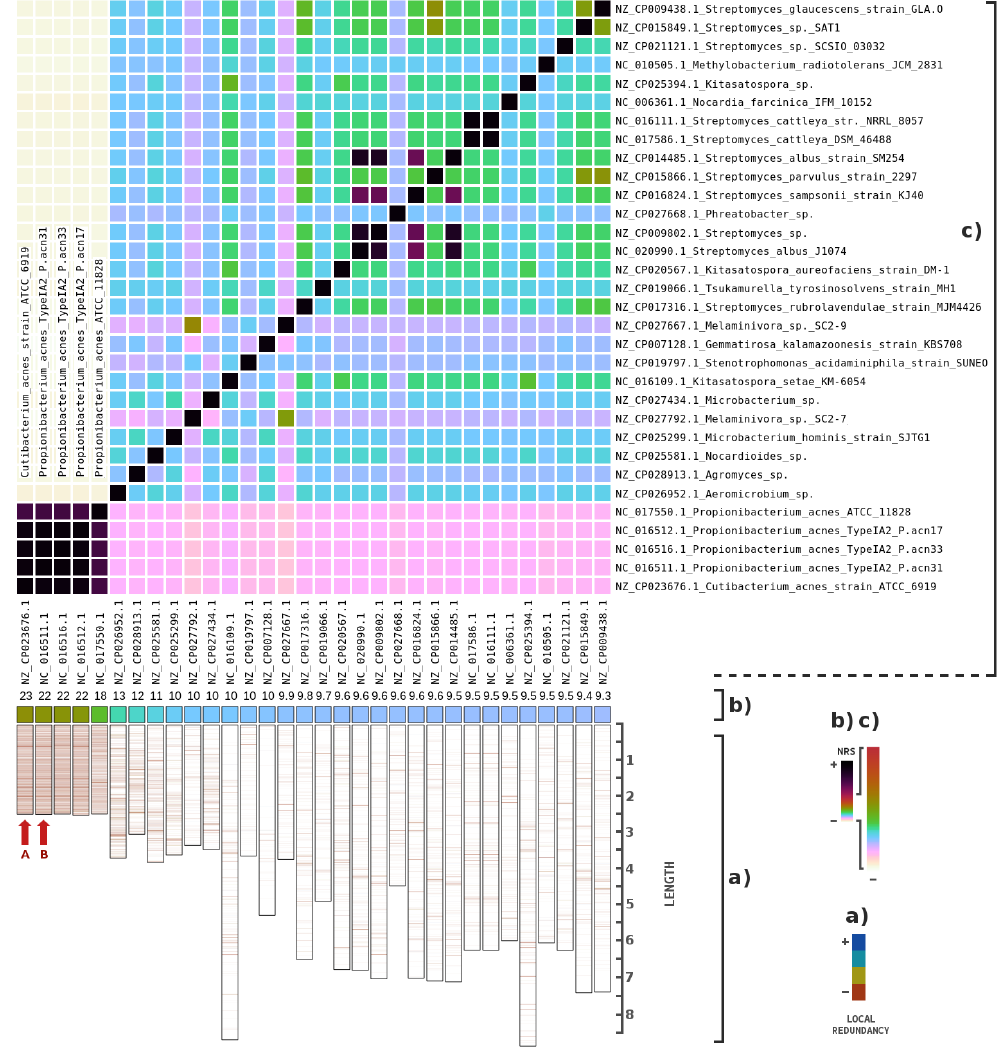
Figure 6. Metagenomic composition analysis of the PUM sample, specifically for bacterial genomes: ( a ) the local similarity (redundancy) of the highest NRS entries in descending order (from left to right), according to the order of the names at the top (from bottom to top). The scale is in megabases; ( b ) the percentage of the highest NRS entries in descending order (from left to right); and ( c ) the bacterial genome intra-similarities based on the NRS. The names of the bacteria and the sequence identifiers are both represented. Letters (in red) identify potential genomes contained in the